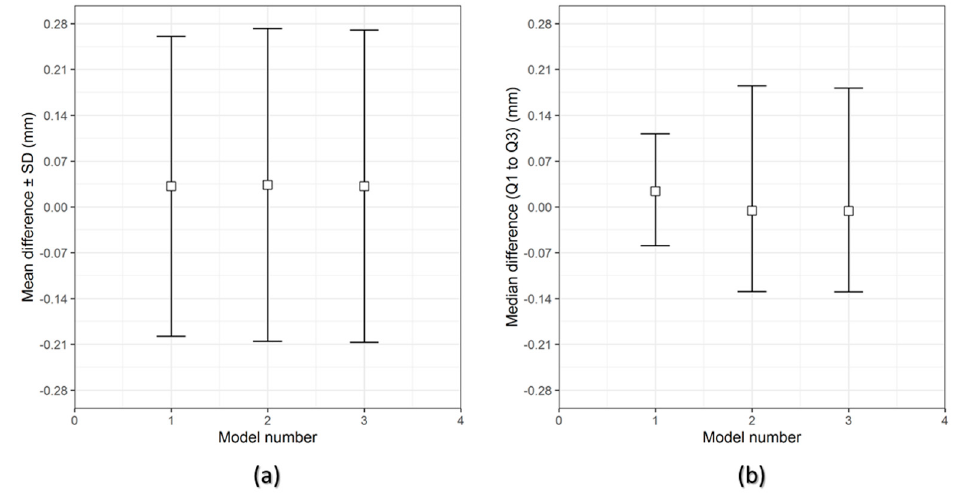
Figure 7. Descriptive data distribution for Group 2 PSIs, illustrating the difference between planned and FFF 3D printed PEEK PSIs (PSI model 1–3). ( a ) mean difference ± SD (mm) and ( b ) median difference (Q1 to Q3) (mm).